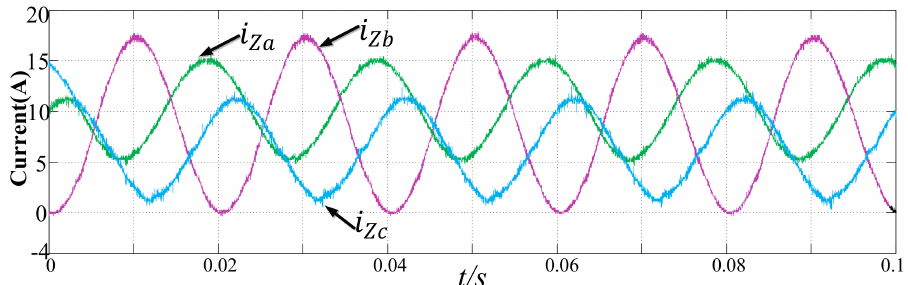
Figure 19. The waveforms of the three-phase circulating